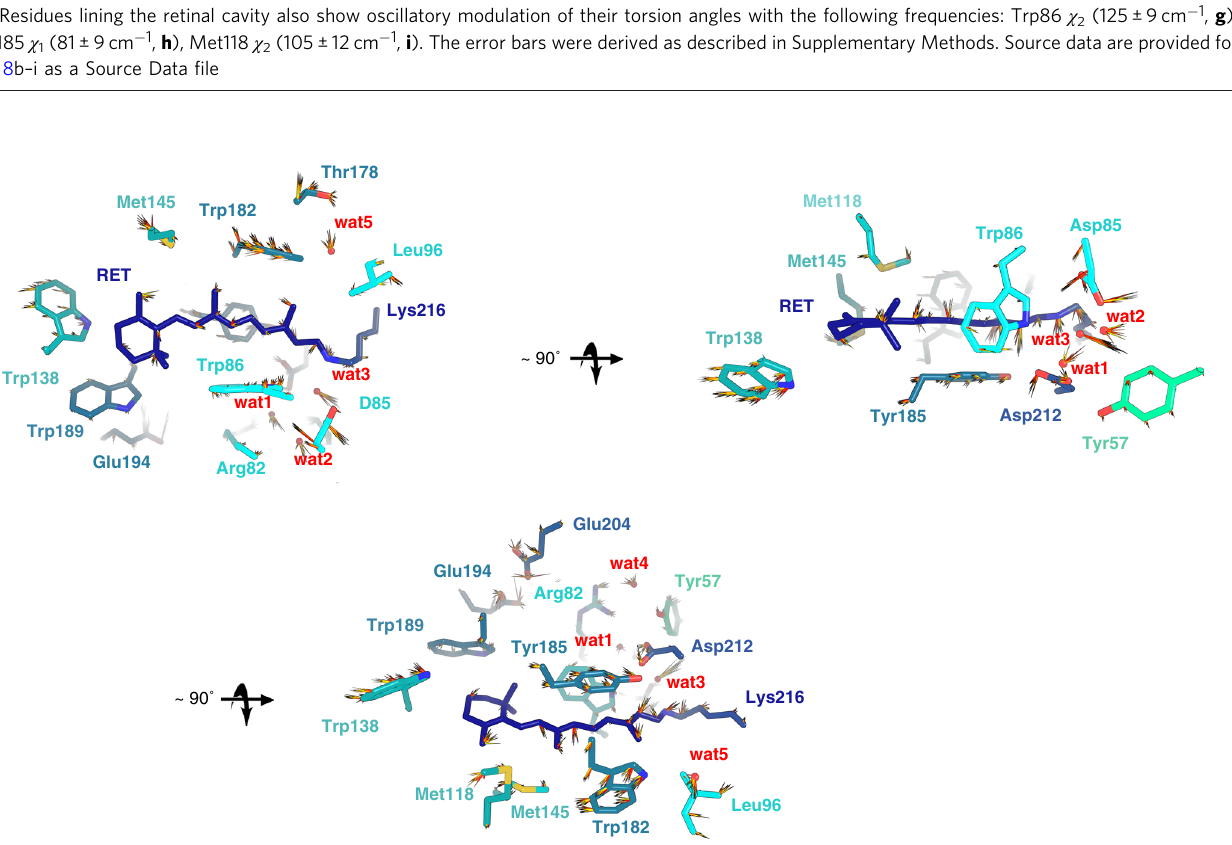
Fig. 9 Ultrafast changes of residues and waters in the immediate vicinity of retinal. Selected residues from the dark “ unpumped ” structure are shown as sticks, with the retinal pigment coloured in dark blue; carbon atoms of surrounding residues coloured in shades of cyan and blue (N-terminal to C-terminal); and nitrogen, oxygen and sulfur atoms coloured in marine blue, red and yellow, respectively. Arrows indicate the movement of atoms on the fs timescale, with the magnitude of motions illustrated by the length of arrows (multiplied fi ve times). Arrows of different colours correspond to different pump – probe delays, with increasingly red-shaded arrows corresponding to longer pump – probe delays, in the 240 – 740-fs range